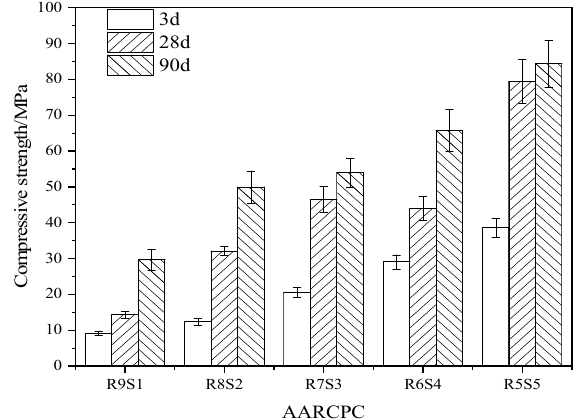
Figure 6. Compressive strength of AARCPC with different slag content.